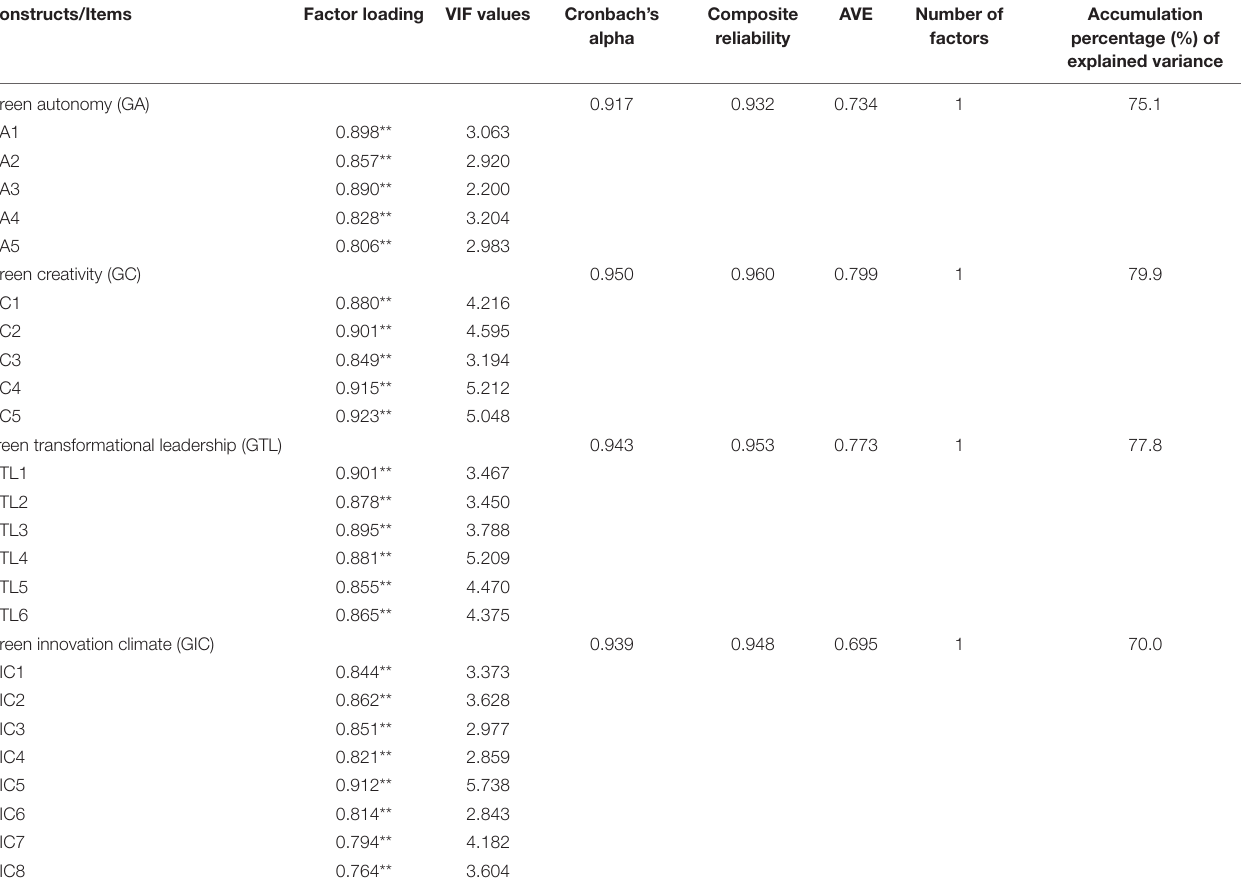
TABLE 1 | Constructs’ reliability, factor loading, average variance extracted (AVE), and accumulated explained variance. Constructs/Items Composite